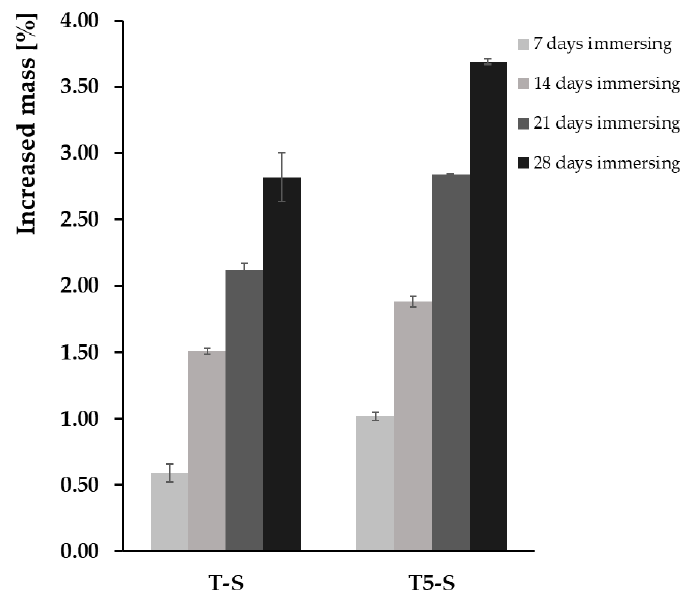
Figure 6. Weight gain of T-S and T5-S with CaTiO 3 (Ca) or hydroxyapatite (HA) layers after immersion in SBF for 7, 14, 21, and 28 days. Table 3. Ca/P ratios obtained from EDS measurements for the T, T5, T-S, and T5-S samples after immersion in SBF for 1–4